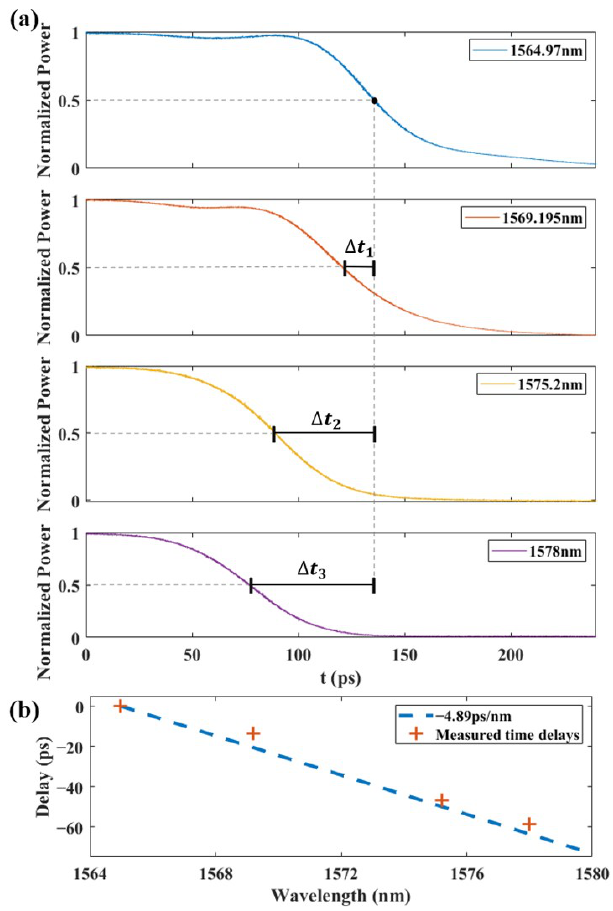
Figure 7. ( a ) Measured time delays at different wavelengths of a falling edge. ( b ) Time delays plotted with the − 4.89 ps/nm linear dispersion